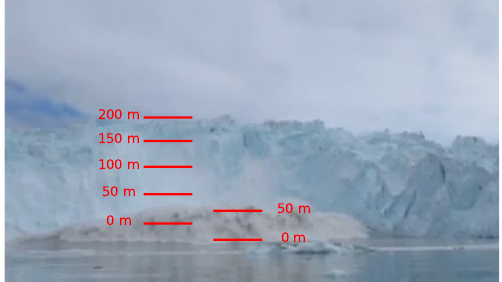
Figure 5. Video still of the tsunami wave taken from the tour boat at 800m distance of the terminus. The tsunami wave bore reaches a maximum wave crest height of 50m. The red horizontal lines indi- cate the projection of the calving front (black dashed lines in Fig. 3) to a distance of 600m from the tour boat.